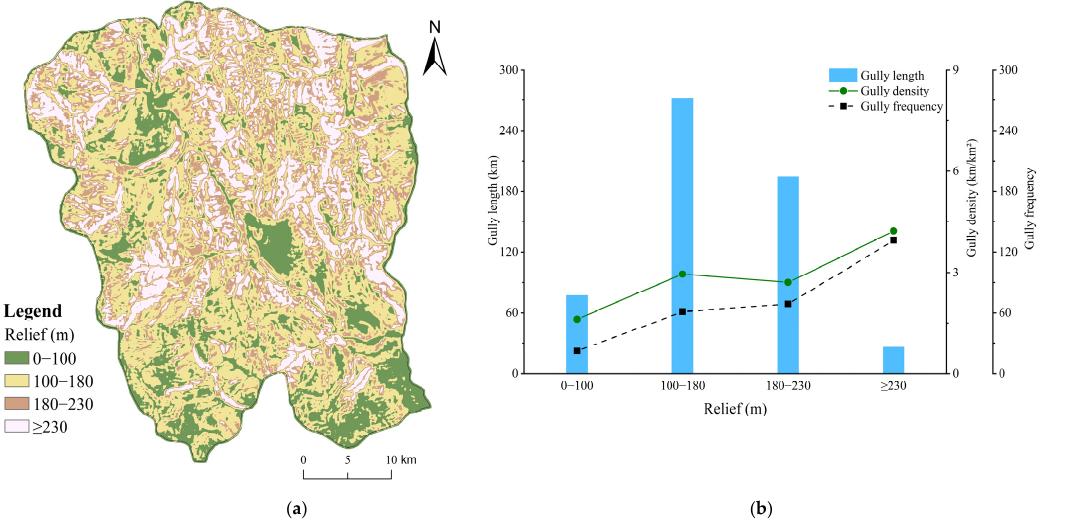
Figure 7. ( a ) Distribution of reclassified relief ranges; ( b ) Characteristics of gully system parameters (gully length, density, and frequency) under different relief ranges.